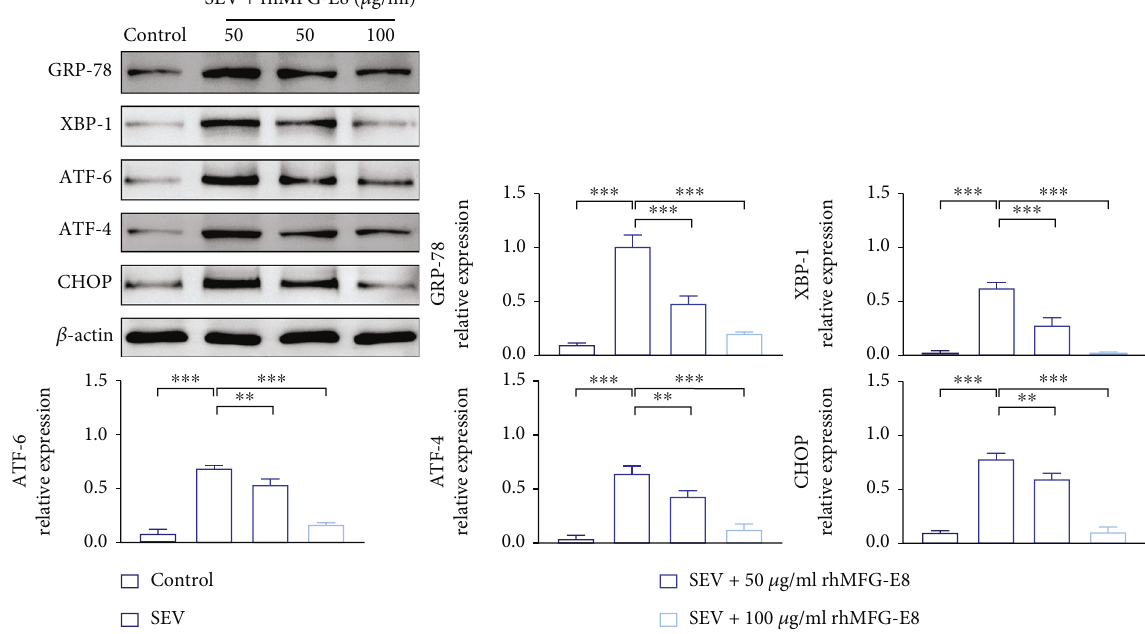
Figure 3: The expression of protein related with endoplasmic reticulum pressure (GRP-78, XBP-1, ATF-6, ATF-4, and CHOP) a ff ected by sevo fl urane, sevo fl urane+50 μ g/ml rhMFG-E8, and sevo fl urane+100 μ g/ml rhMFG-E8. ∗ p < 0 : 005 , ∗∗ p < 0 : 001 , ∗∗∗ p < 0 : 0001 .